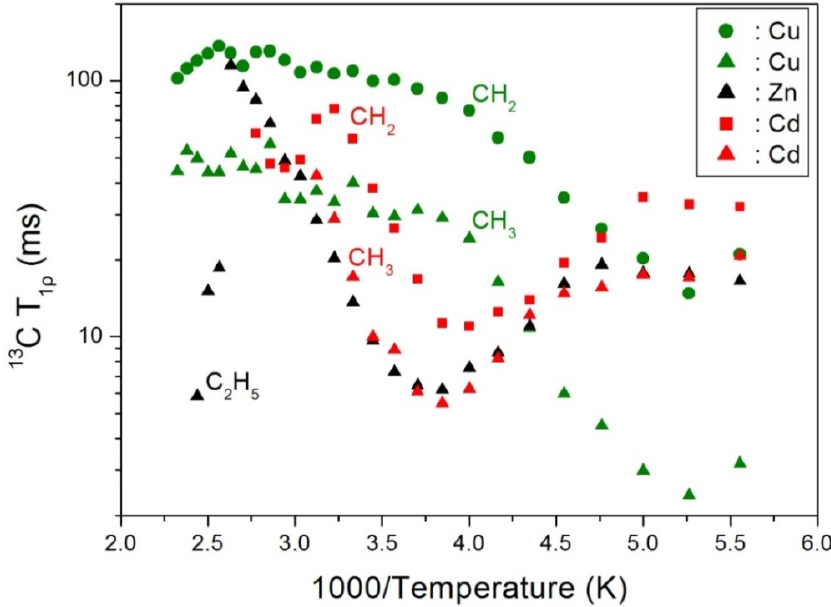
Figure 8. 13 C spin ‐ lattice relaxation times T 1 ρ in the rotating frame in (C 2 H 5 NH 3 ) 2 M Cl 4 ( M = Cu, Zn, and Cd) as a function of inverse temperature.